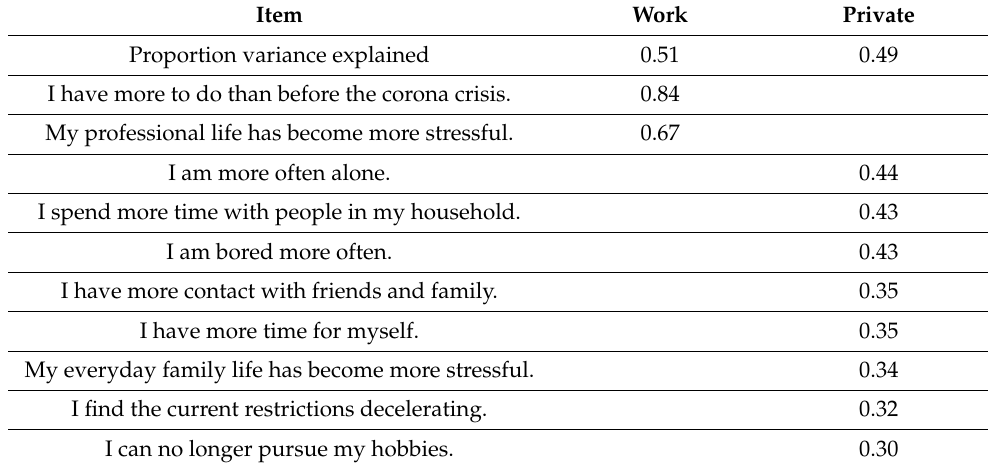
Table 3. Factor solution of the items on everyday life.